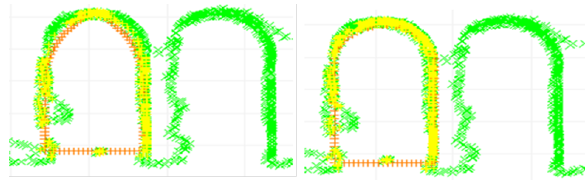
Figure 8: Inter class model selection between templates of a gothic (brown pluses on the left side) and an arched-dormer (right side) window. The inliers (yellow crosses) show a strong evidence for the arched-dormer window compared to the gothic at this position of the